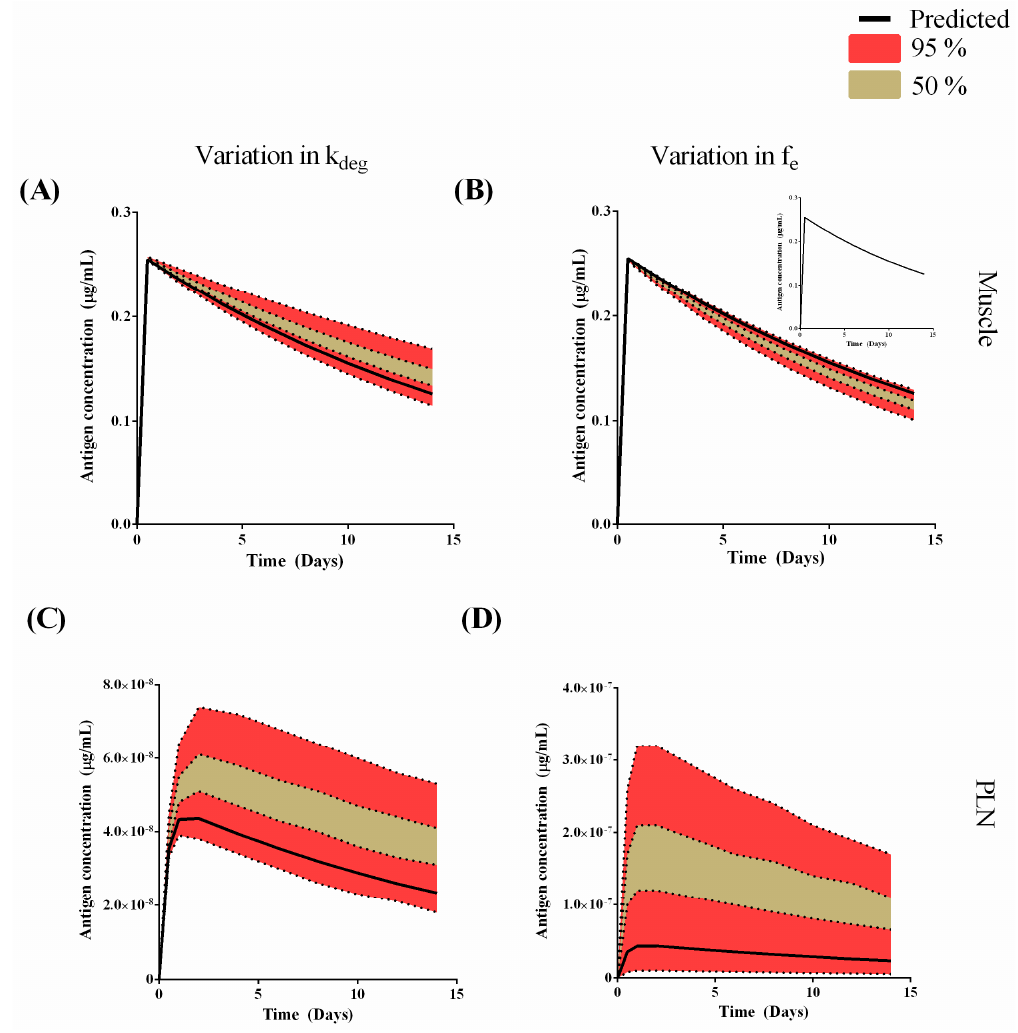
Figure 8. Model predictions (black solid line) and global sensitivity analysis for muscle ( A , B ) and PLN ( C , D ). ( A , C ) show a ± 50% variation in k deg ; ( B -insert) and ( D ) show a variation in f e from 1 × 10 − 8 –1 × 10 − 5 ; ( B ) shows a variation in f e from 1 × 10 − 5 –1 × 10 − 1 .